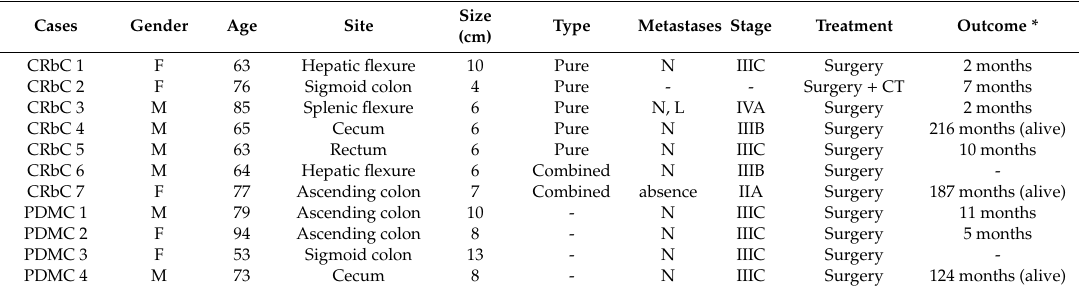
Table 2. Clinicopathological data of CRbCs and poorly di ff erentiated medullary carcinomas (PDMC) included in our